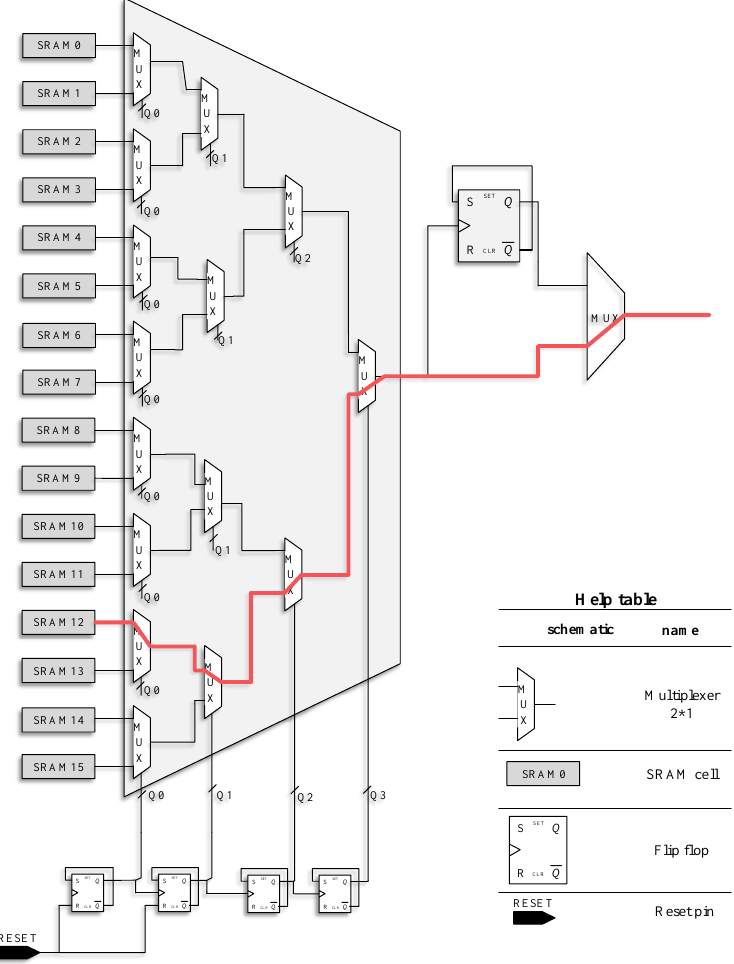
Figure5. SRAM cell and related path in diagnosing